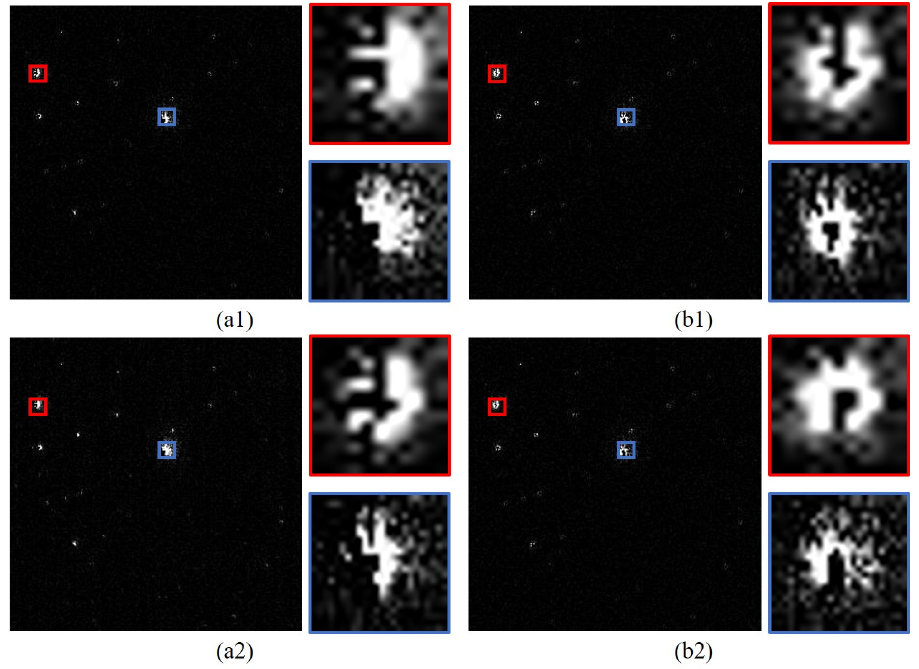
Figure 9. Region 2 in the difference images using ( a ) affine transformation and ( b ) homography transformation. ( a1 , b1 ) The difference image of the second frame and the reference image. ( a2 , b2 ) The difference image of the tenth image and the reference image.